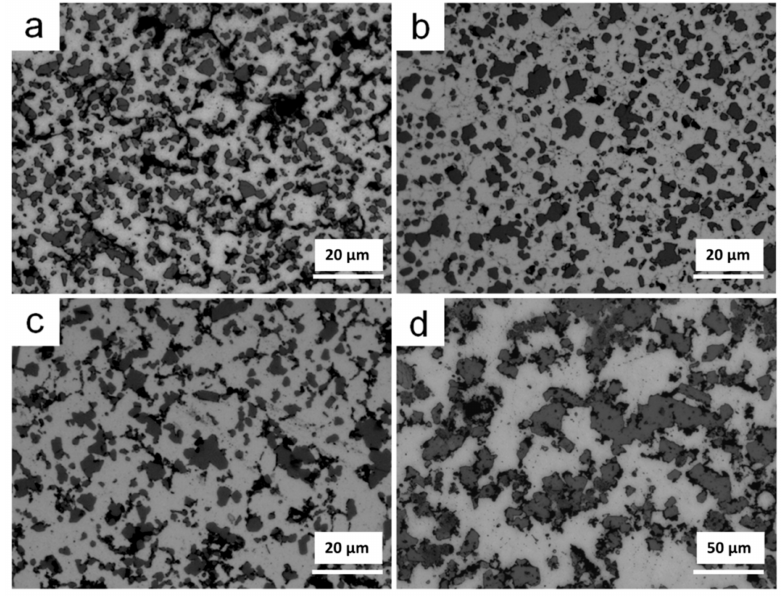
Figure 9. Optical microstructures of parts sintered at 550 ◦ C for ( a ) 1 h; ( b ) 3 h, ( c ) 5 h and ( d ) 8 h. Images of the green parts A and B, and their solvent debinded parts and sintered parts (sintered